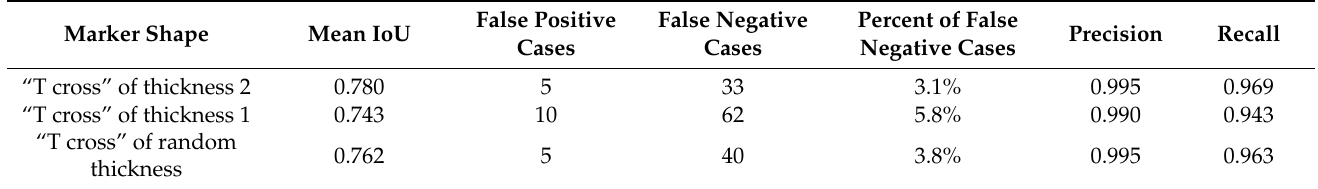
Table 5. Testing the “T cross” marker shape that was performed with a combined images dataset of 10,797 images with a width of 416 pixels each.